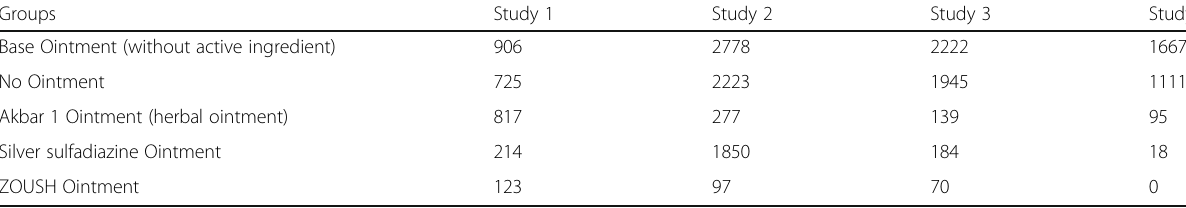
Table 3 Mean count of Pseudomonas aeruginosa isolated in each study phase. (CFU/g)